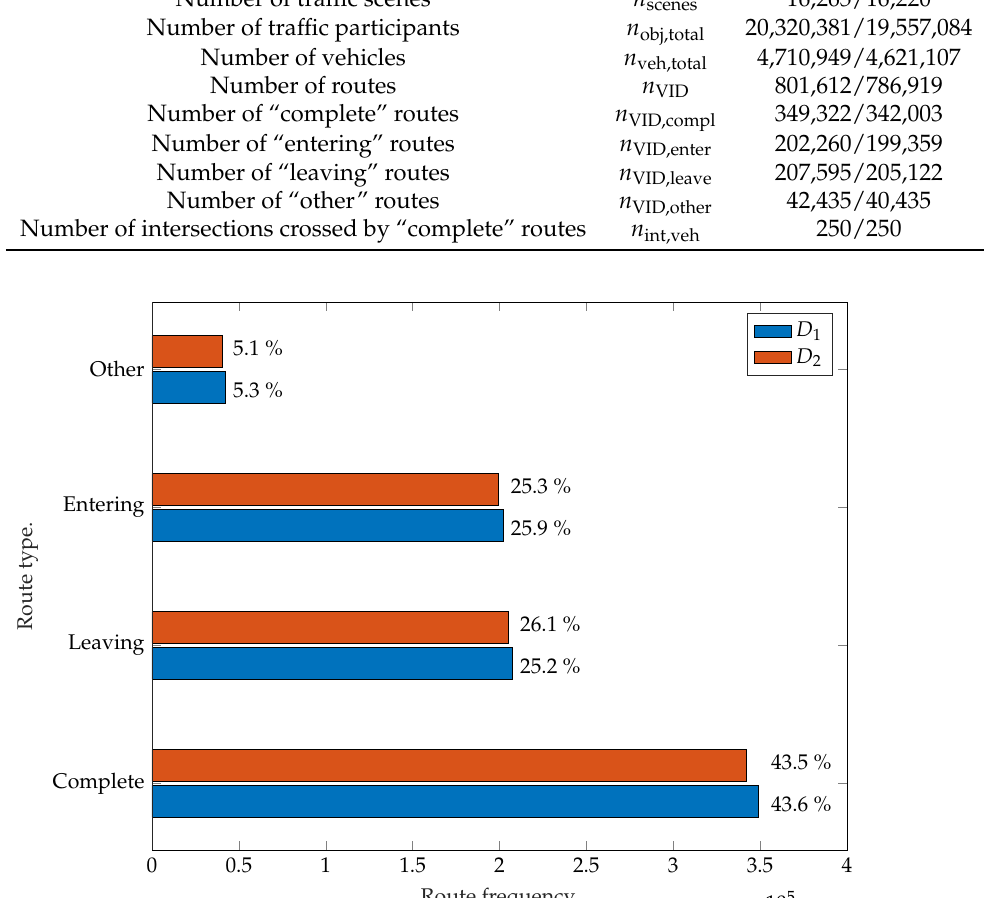
Figure 14. Shown is the route distribution according to Section 3.2: complete, outgoing, entering, and Figure 14. Route distribution according to Section 3.2: complete, outgoing, entering, and other.